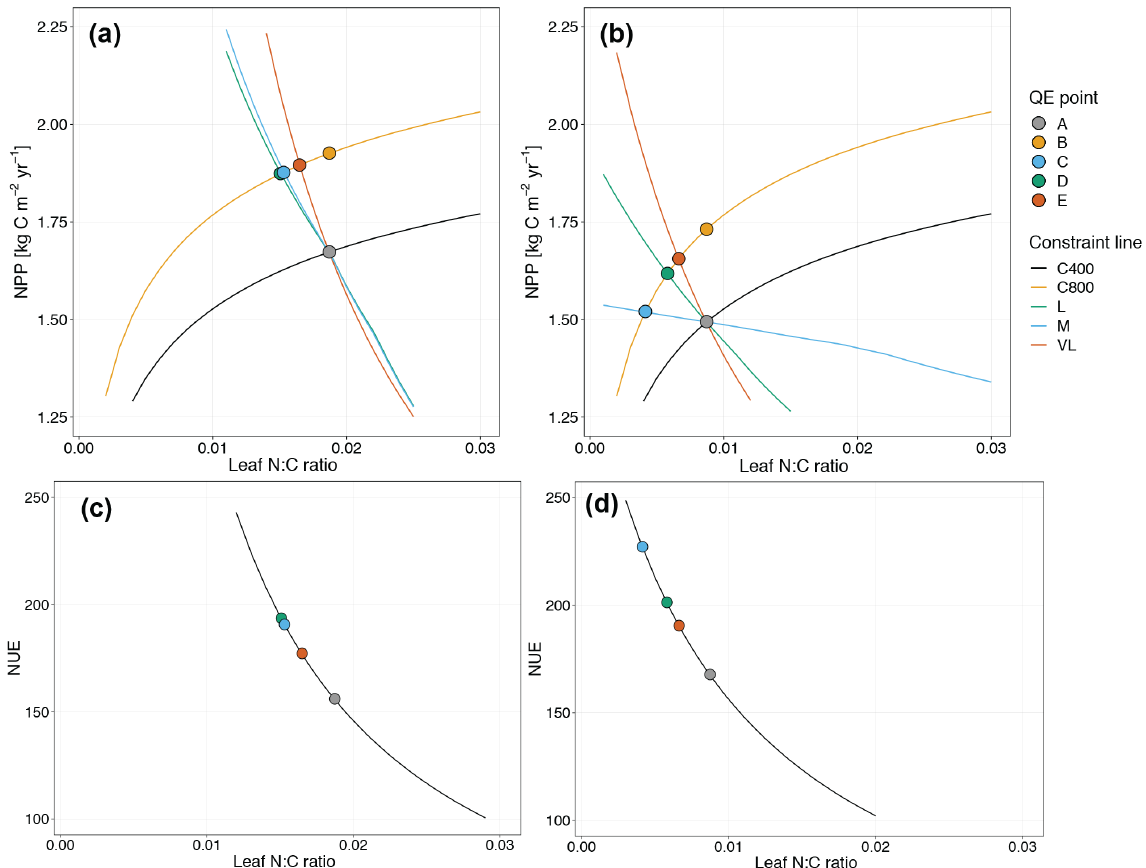
Figure 6. Graphic interpretation of the priming effect on plant net primary production (a, b) and nitrogen use efficiency (c, d) response to CO 2 fertilization under variable wood N:C ratio (a, c) and fixed wood N:C ratio assumptions (b, d) . Constraint lines C400, C800, M, L, and VL refer to photosynthetic constraints at CO 2 = 400ppm, CO 2 = 800ppm, medium-term, long-term, and very-long-term nutrient recycling constraints, respectively. Point A is the quasi-equilibrium point at CO 2 = 400ppm, point B is the instantaneous response point at elevated CO 2 , and points C, D, and E are the M-, L-, and VL-term equilibrium points at elevated CO 2